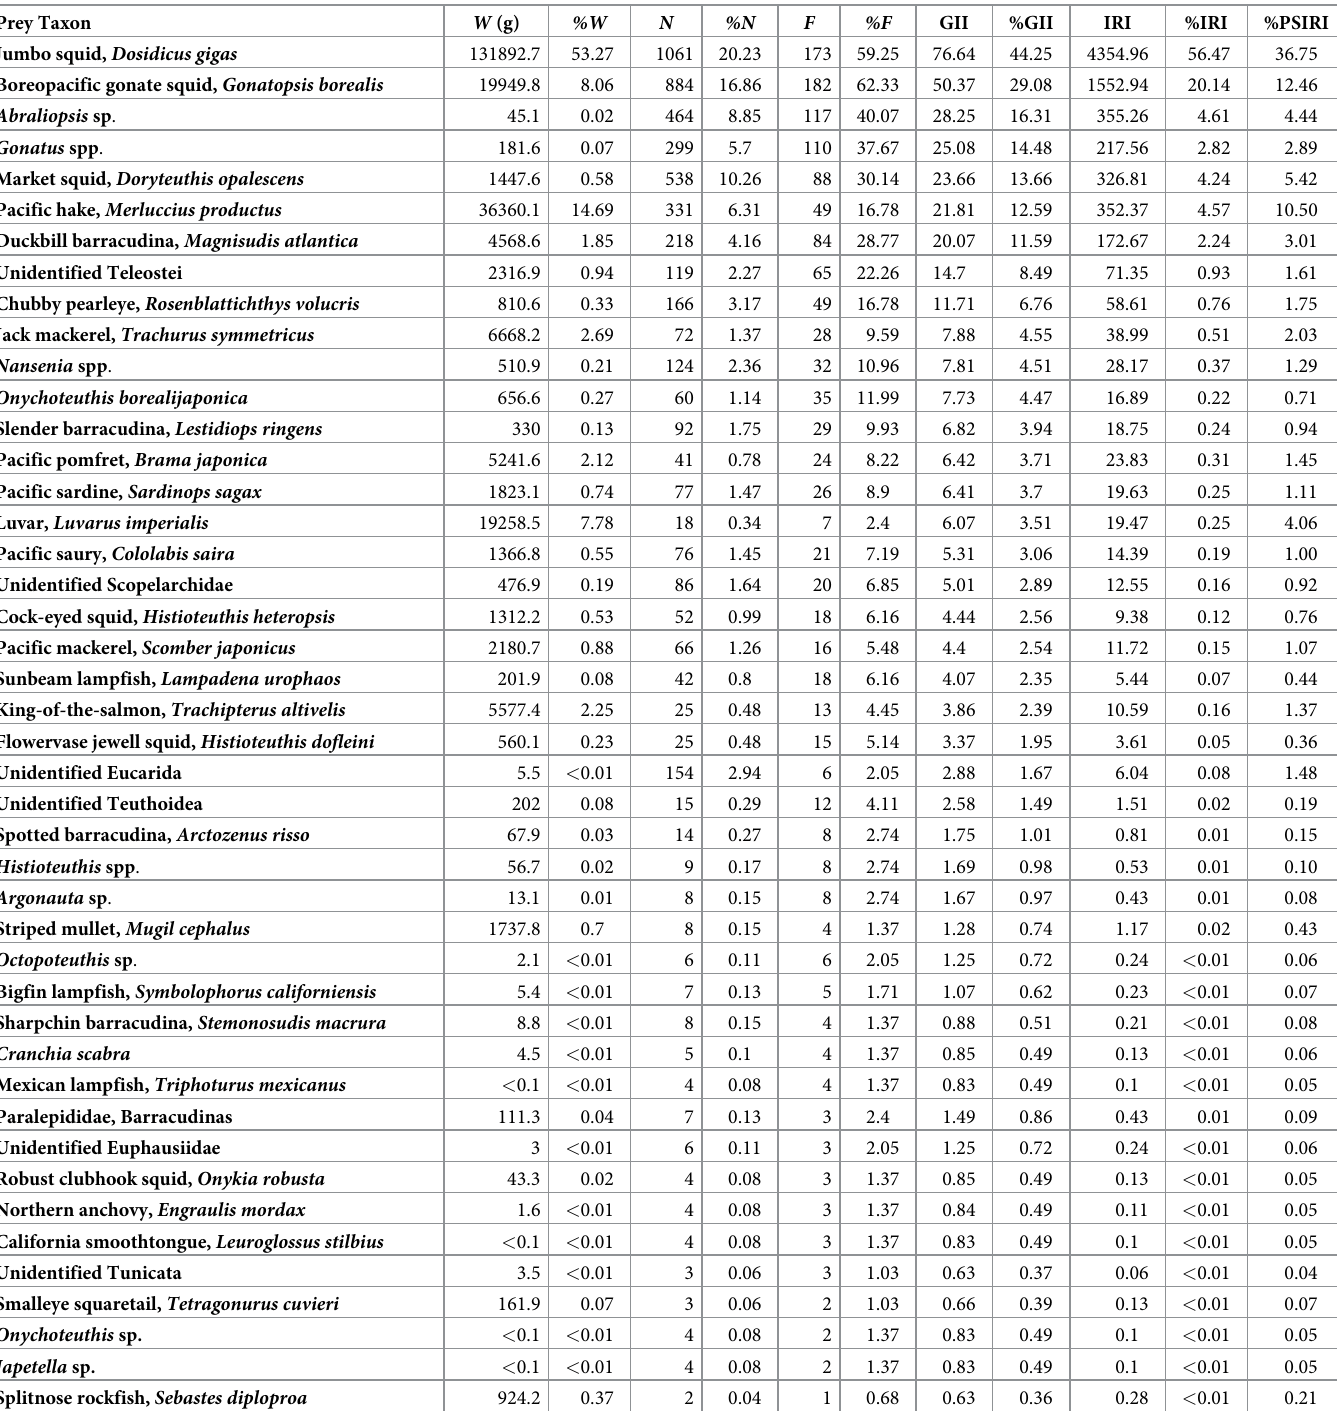
Table 3. Quantitative prey composition of the broadbill swordfish ( Xiphias gladius ) in the CCLME. A total of 292 stomachs containing food was examined. Prey items are shown in order of decreasing GII value. W = weight (g) for the given prey taxon, %W is the same value expressed as a percentage of the total weight summed across all prey taxa; N = number of prey individuals; F = frequency of occurrence (number of stomachs in which the prey taxon occurred); %F = frequency of occurrence expressed as a percentage of the number of (non-empty) stomachs examined; GII = geometric index of importance; IRI = index of relative importance; % PSIRI = percentage prey-specific